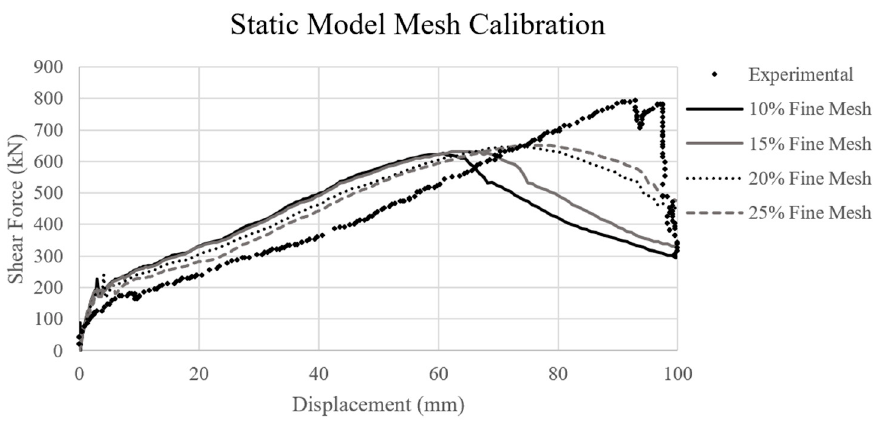
Figure 7. Static force vs. displacement graph of various fine meshes.